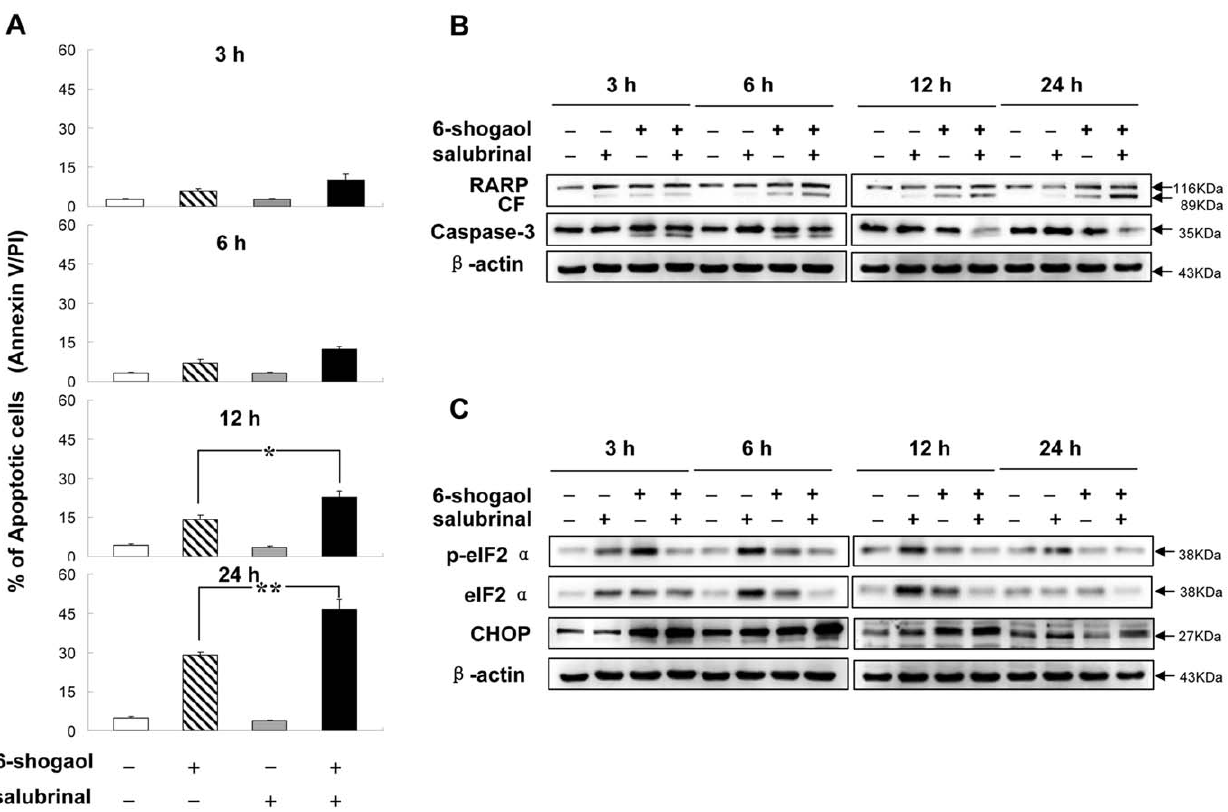
Figure 4. Effects of co-administration of salubrinal and 6-shogaol on apoptosis and phosphorylation of eIF2 a . SMMC-7721 cells were pretreated with 5 m M salubrinal for 2 h, followed by treatment with 20 m M 6-shogaol for 3, 6, 12, and 24 h. (A) Apoptosis was determined using flow cytometry. *Values for cells treated with salubrinal and 6-shogaol in combination were significantly greater than those for cells treated with 6-shogaol alone by Student’s t -test; P , 0.05. Total protein extracts were prepared and subjected to Western blot assay using antibodies against PARP and caspase-3 (B), and eIF2 a pathway related proteins (C). CF stands for cleavage fragments of PARP.